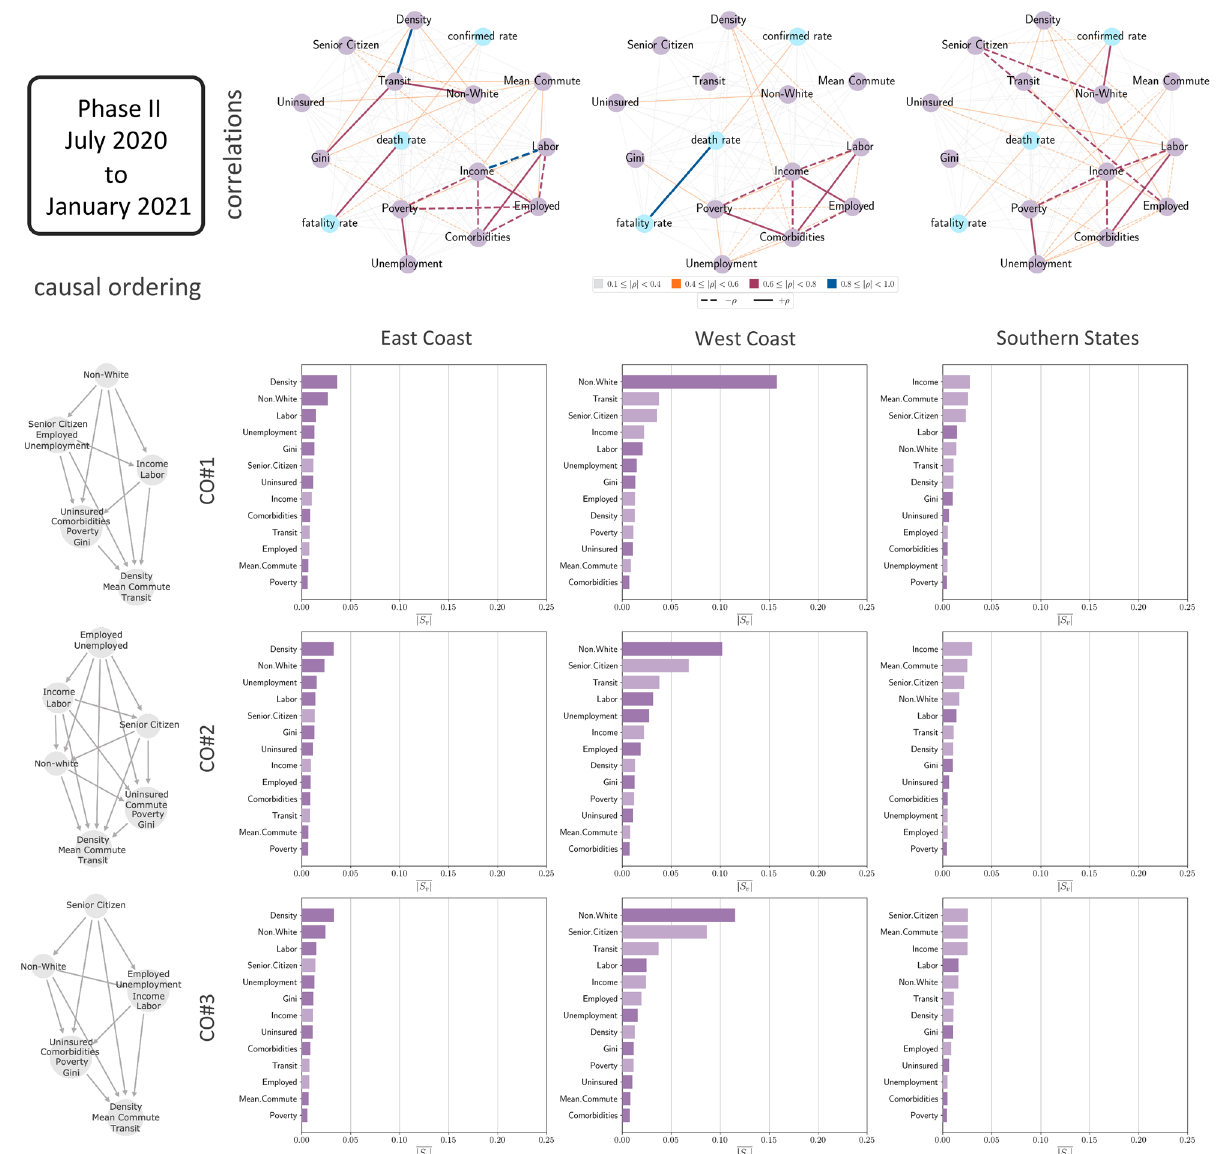
Figure 4. The causal connection between the socioeconomic metrics that we consider in this work and confirmed case rates in various regions of the USA for July 2020 to January 2021. The states included in the East Coast region are District of Columbia, New Jersey, Rhode Island, Massachusetts, Connecticut, Maryland, Delaware and New York. The ones in the West Coast region are California, Oregon and Washington. The states in the Southern States region are Alabama, Arkansas, Florida, Georgia, Kentucky, Louisiana, Mississippi, North Carolina, Oklahoma, South Carolina, Tennessee, Texas, Virginia and West Virginia. The networks in the top row show the correlations between the different metrics in the three regions. The graphs in the left column of the plot show the three partial causal orderings that we consider in this analysis. Each panel of the array of bar plots show the hierarchy of the metrics in terms of mean absolute causal SHAP values, | S v | , for a particular region and causal ordering. The lighter shaded bars indicate a negative effect of the metric on the confirmed case rates while the darker bars indicate a positive The Phase II results in the lower half of Table 1 has similar results as Phase I and shows that socioeconomic metrics affect the spread of COVID-19 significantly, especially in the West Coast states. The primary difference between Phase I and Phase II is that some of the effects of the socioeconomic metrics on the spread of COVID- 19 decreases in Phase II compared to Phase I as presented in our previous analysis, especially for the East coast and the Southern States regions. These results highlight two implications of the causal analyses. Firstly, the initial health care policy intervention of some of the US states and the federal government seem to have helped in reducing the differential in the spread of the pandemic from what was seen at the initial stage and was dispro- portionately affecting the more vulnerable. Secondly, socioeconomic metrics prove to be important in shaping the possible policy interventions to control the spread of the pandemic.